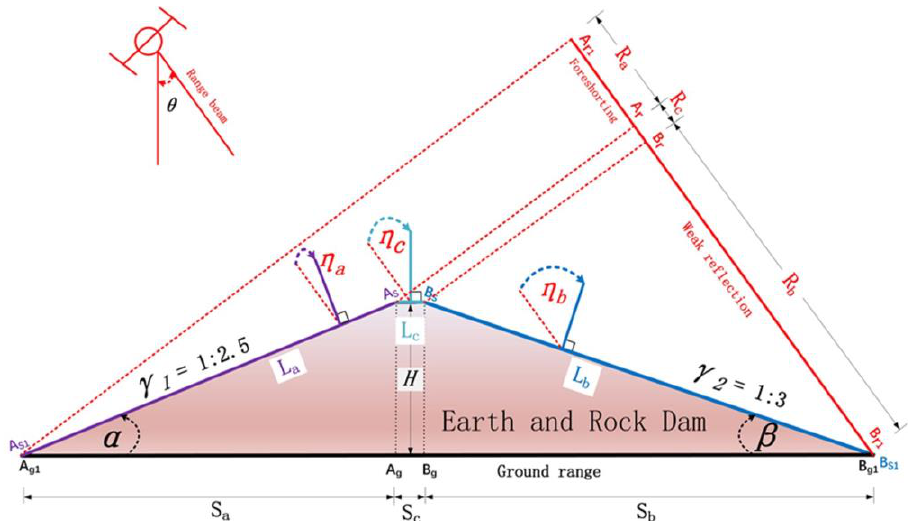
Figure 1. The middle-sized earth- and rock-filled dam transverse section and radar reflection geometry.